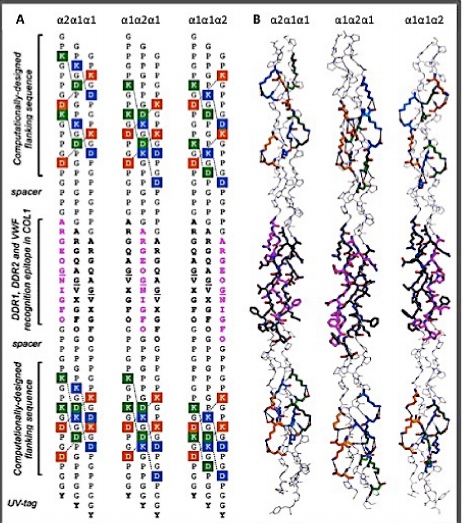
Figure 3. The heterotrimeric peptides modeling the collagen-binding epitopes on type I collagen (21). ( A ) The design and the amino acid sequences of the heterotrimers mimicking type I collagen in three different registers: α 2 α 1 α 1, α 1 α 2 α 1, and α 1 α 1 α 2; here X is norleucine, a methionine bioisostere. The N- and C-termini flanking sequences are generated by a computer program utilizing genetic algorithm to optimize the location of the Lys-Asp charge-pairings in the helix. ( B ) The corresponding crystal structure of the heterotrimers in three